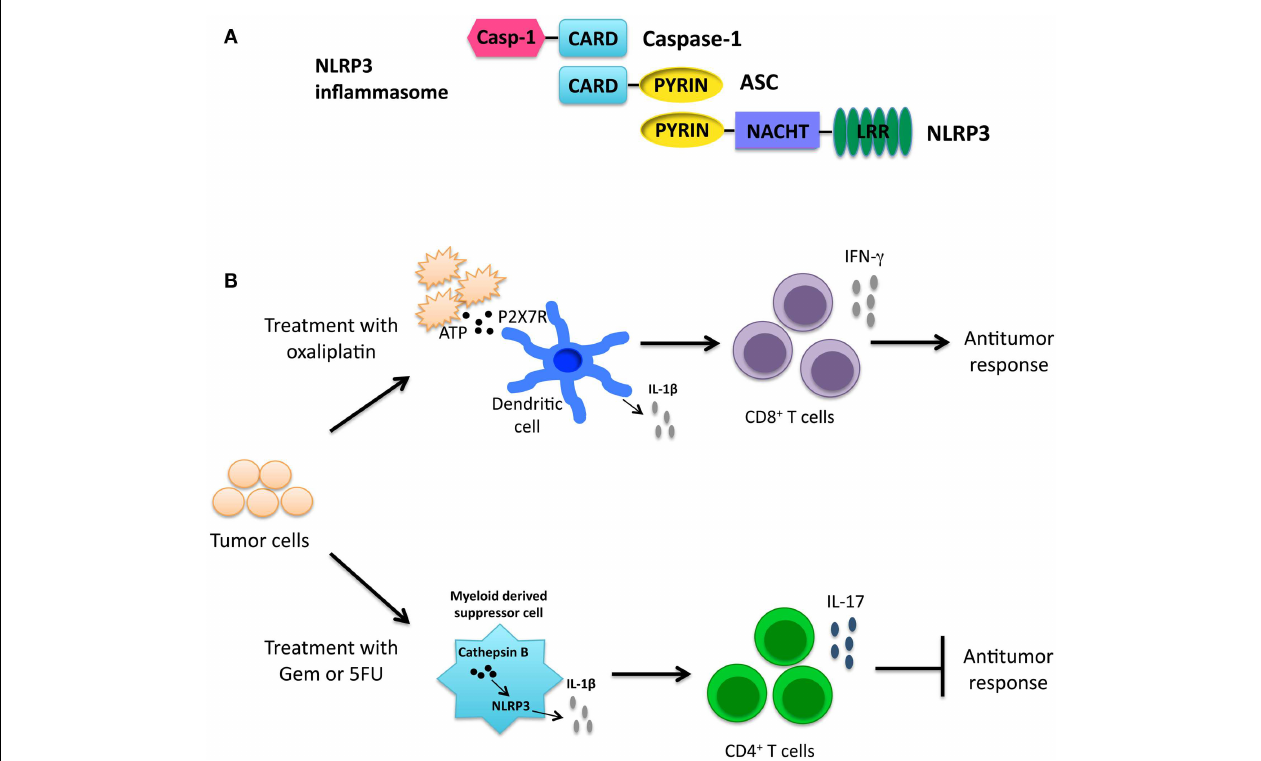
primes anti-tumor CD8 + T cells and promotes the anti-tumor response (66). In contrast, gemcitabine (Gem) and 5-fluorouracil (5FU) activate the NLRP3 inflammasome via release of cathepsin B in myeloid derived suppressor cells leading to IL-1 β secretion. IL-1 β promotes CD4 + T cells to secrete the cytokine IL-17, which blunts the anti-tumor response